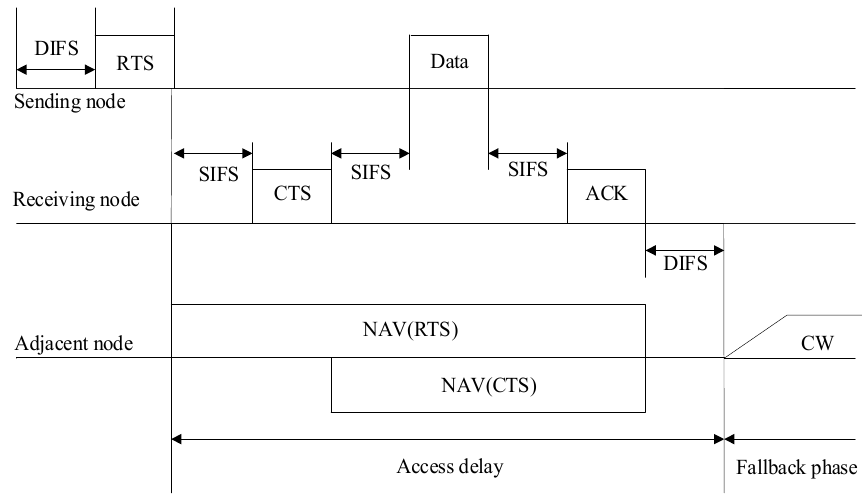
Figure 3. Data transmission step after the node accesses the channel.